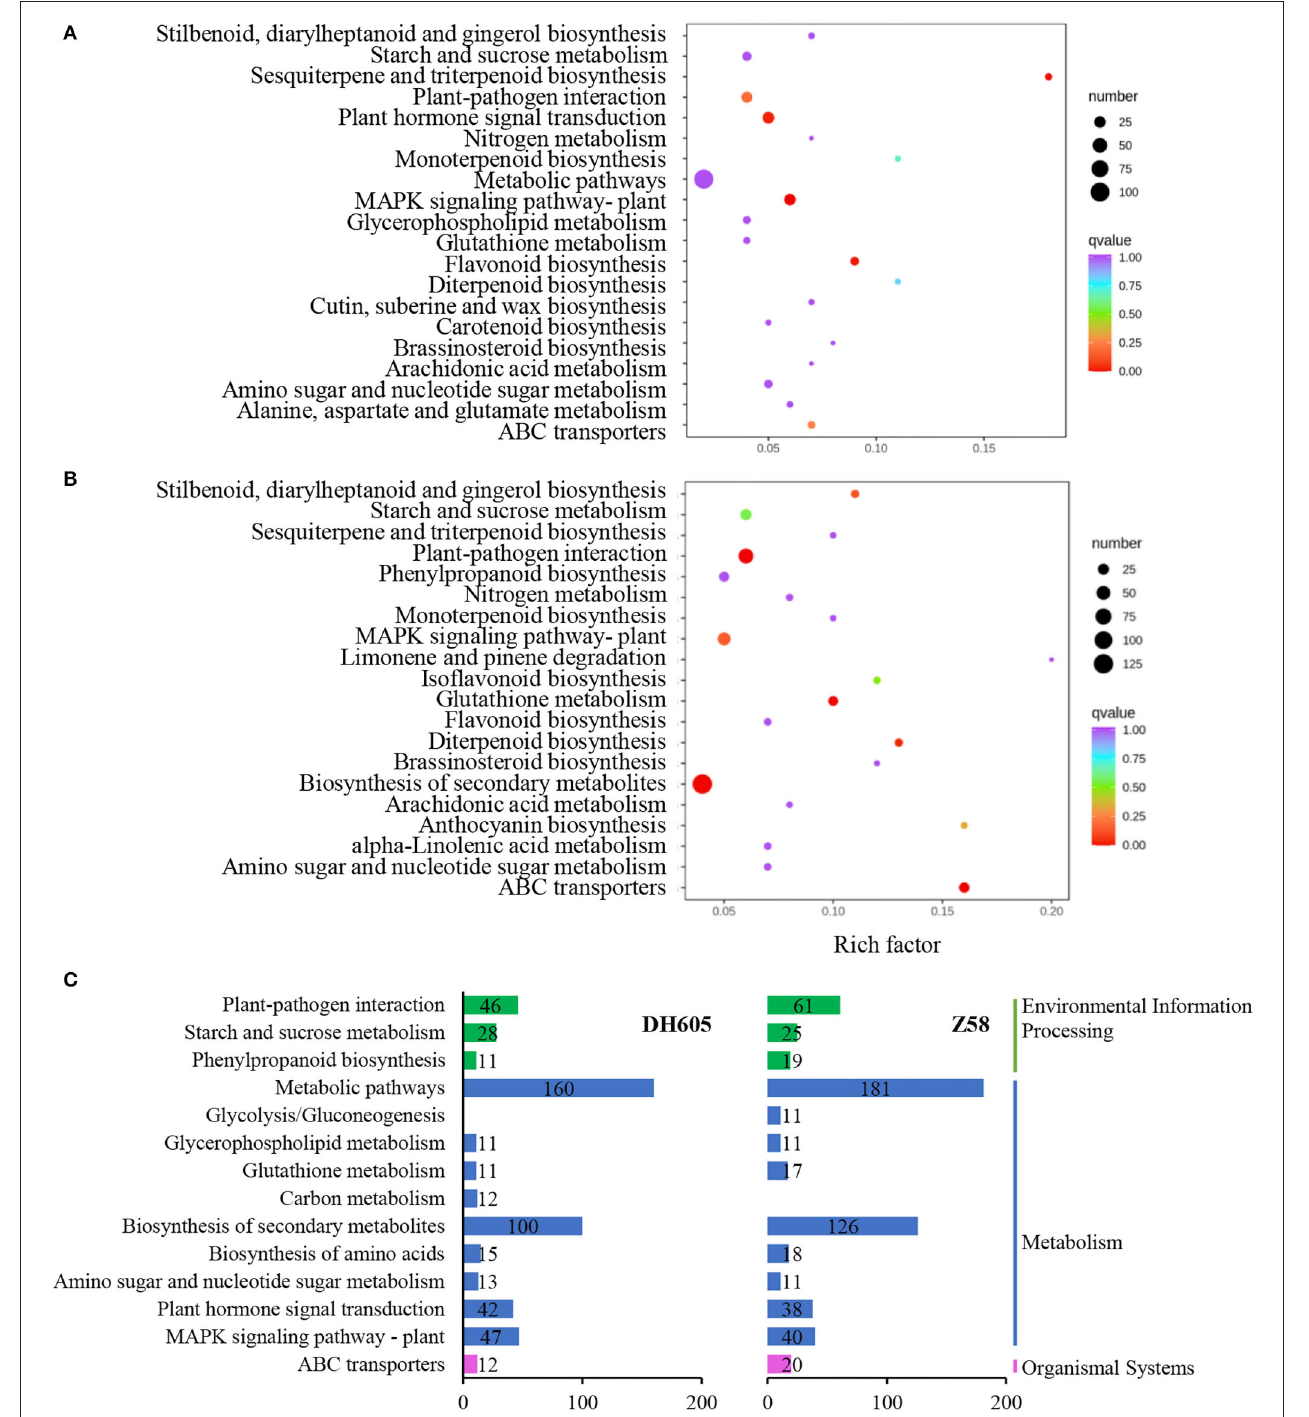
FIGURE 3 | KEGG pathway analysis of DEGs under K + deficiency treatment in DH605 and Z58. (A) KEGG pathway enrichment of DEGs under K + deficiency treatment in DH605. (B) KEGG pathway enrichment of DEGs under K + deficiency treatment in Z58. (C) The top-level pathways of DEGs under K + deficiency treatment in DH605 and Z58 ( p ≤